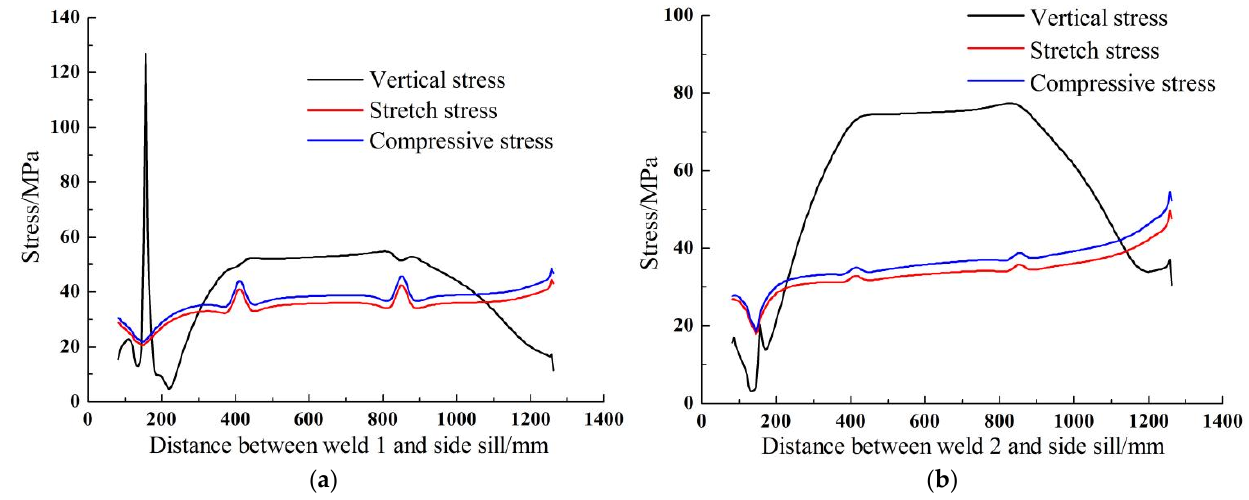
Figure 5. The stress distributions of cross bearer welds under different load. ( a ) weld 1, ( b ) weld